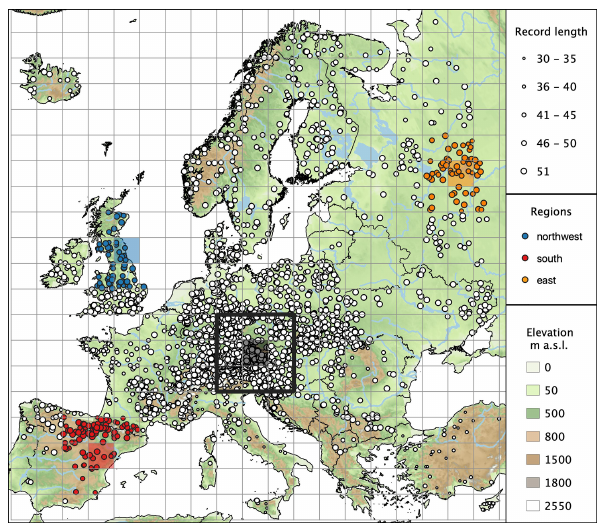
Figure 1. Location of 2370 hydrometric stations in Europe and re- gions considered in this study. The size of the circles is propor- tional to the length of flood records. The grid size is 200km. The black bordered region shows the size of the spatial moving win- dows analysed in Sect. 3.2. It consists of nine cells, corresponding to 600km × 600km, whose central cell is shaded black. Three re- gions analysed in Sect. 3.3, respectively located in northwestern, southern and eastern Europe, are shown with coloured circles, and the shaded regions represent their central cells.